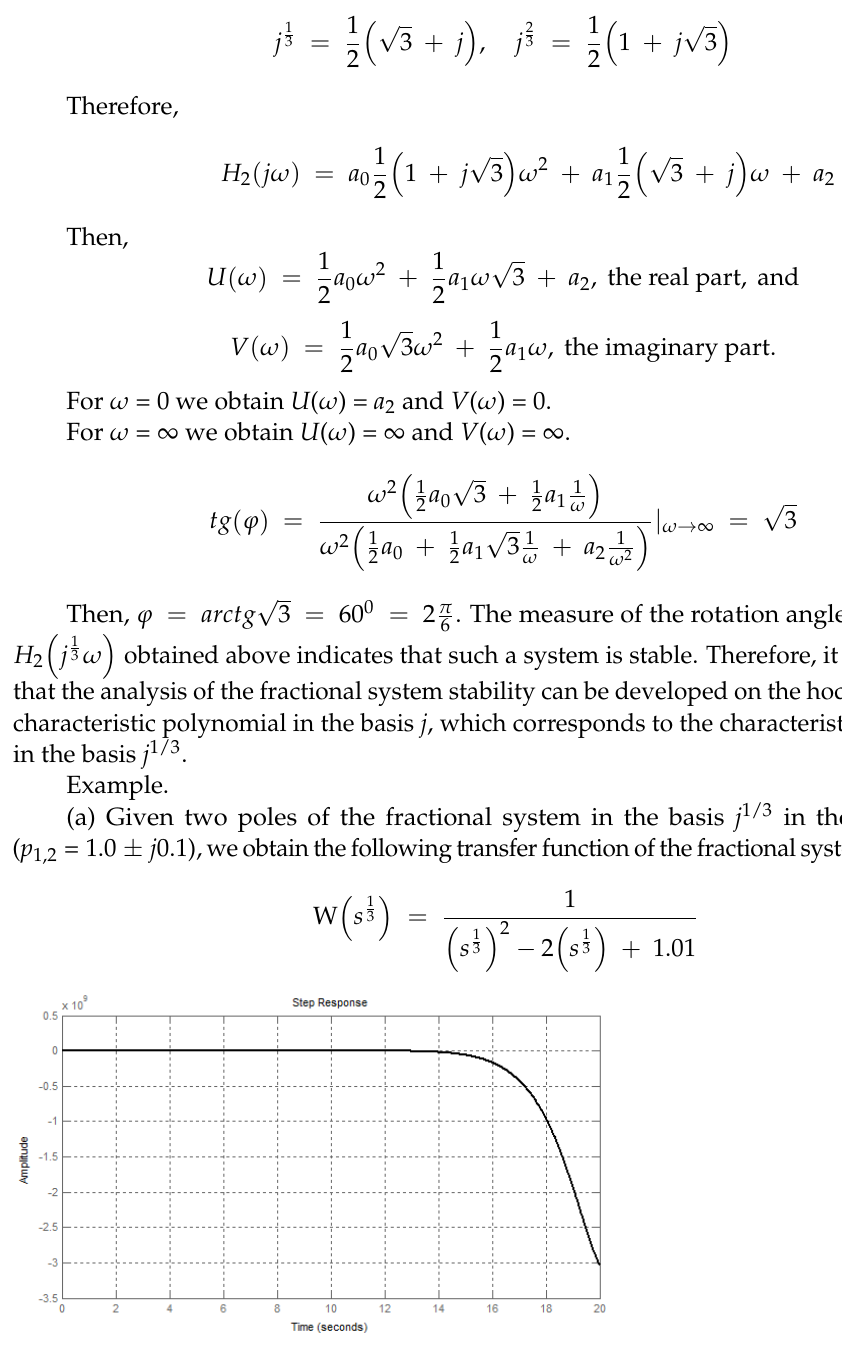
Figure 18. The transition function in this case.